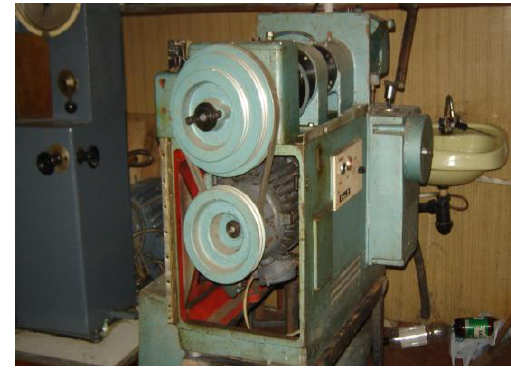
Fig.3 Electric furnace SSHO-3,